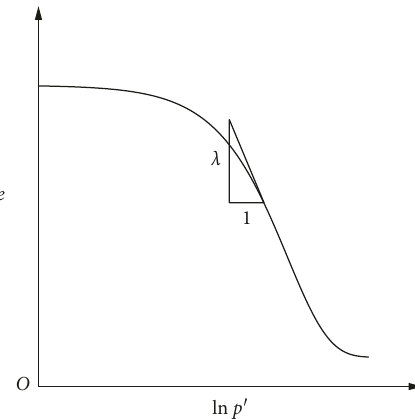
Figure 3: The compression curve of